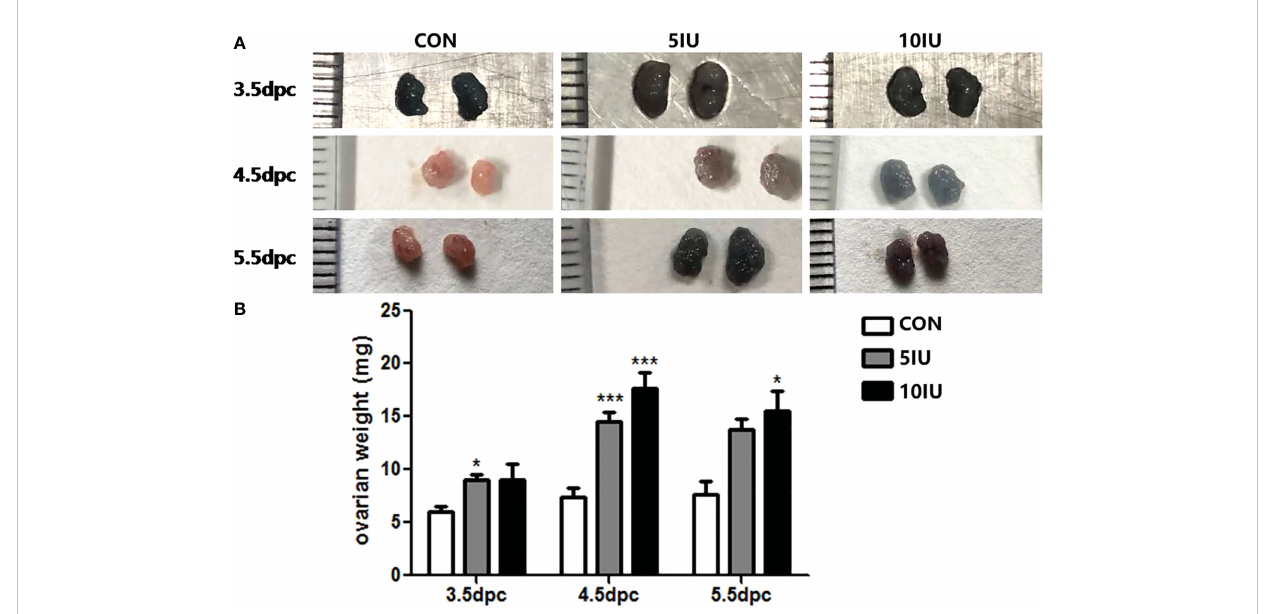
FIGURE 1 Ovarian morphologies and ovarian weights in the CON, 5 IU and 10 IU groups from 3.5 dpc to 5.5 dpc. (A) Changes in ovarian morphology from 3.5- 5.5 dpc among the three groups. (B) Change in ovarian weight from 3.5-5.5 dpc among the three groups. The blue colour of the ovary in Figure A is due to the injection of trypan blue into the tail vein of the mouse. Compared with the control group, *p<0.05,